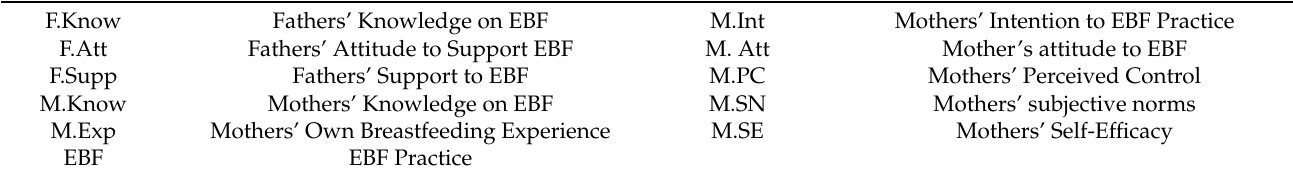
Table 2. List of variables along with abbreviation.